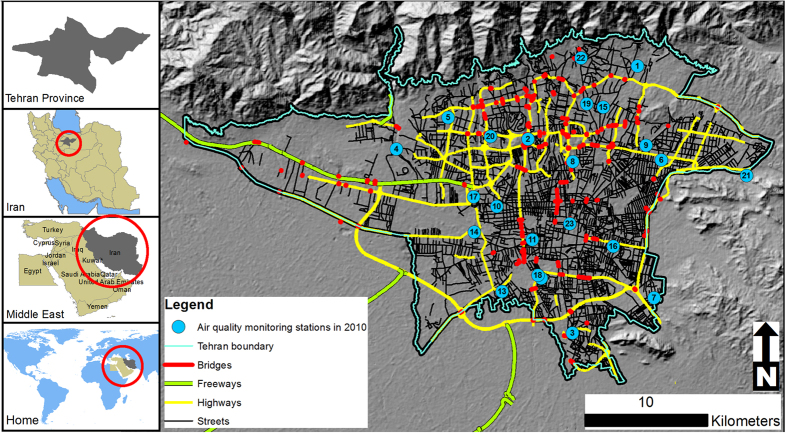
The study area of Tehran, Iran showing locations of 23 air quality monitoring stations in 2010.The figure is generated using ESRI’s ArcGIS 10.2.1 for Desktop (ESRI, Redlands, CA, USA, http://www.esri.com/).